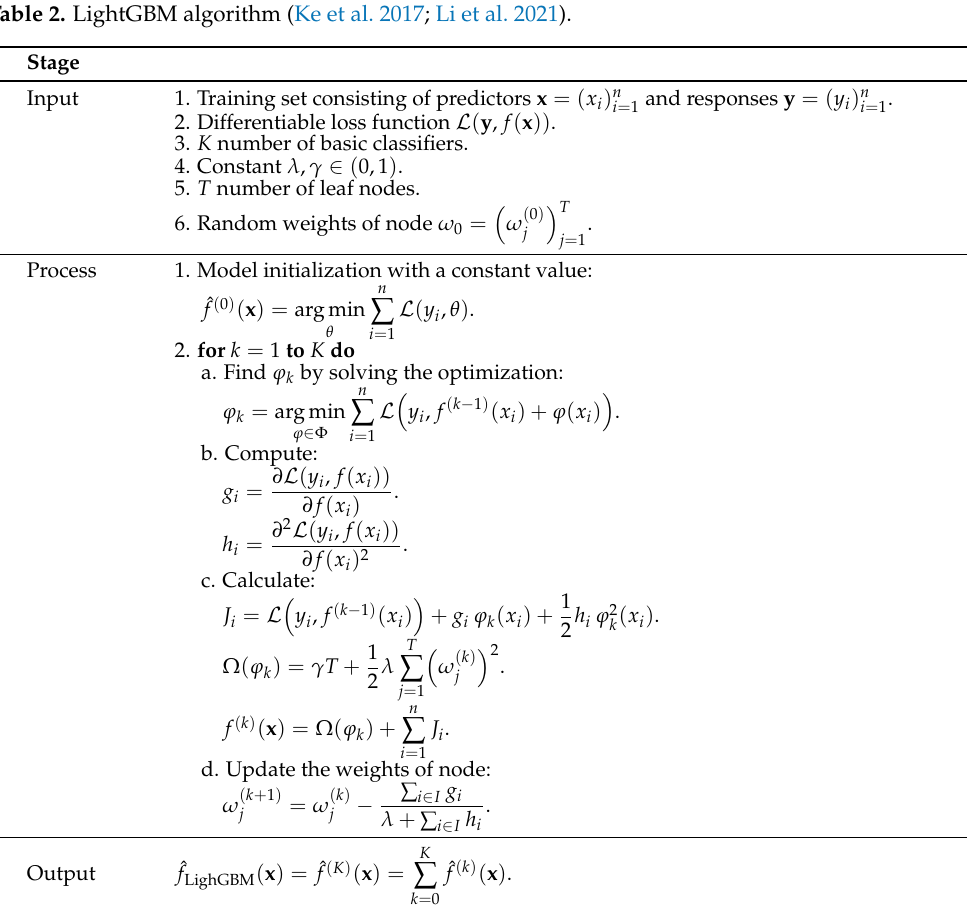
Table 2. LightGBM algorithm (Ke et al. 2017; Li et al.